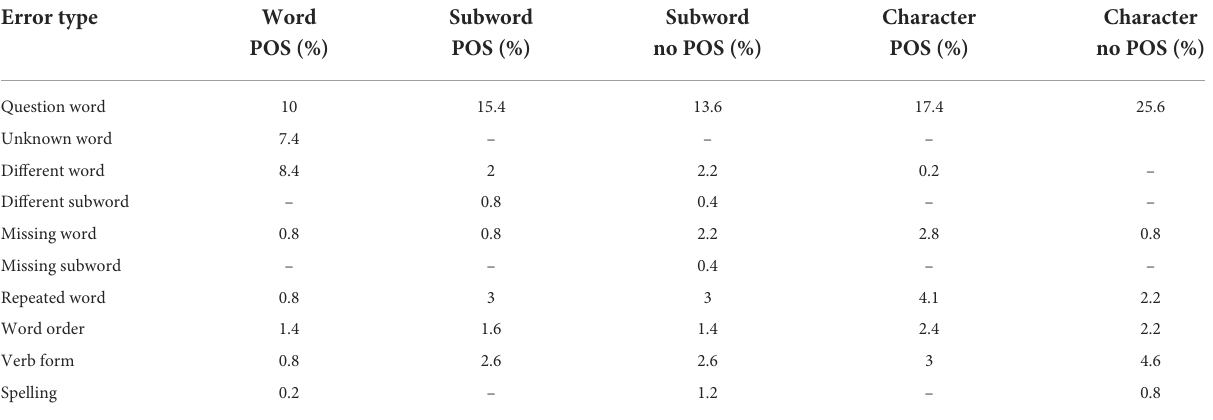
TABLE 5 Distribution of error types in the 500 sample for models trained on clean QUACC. Error